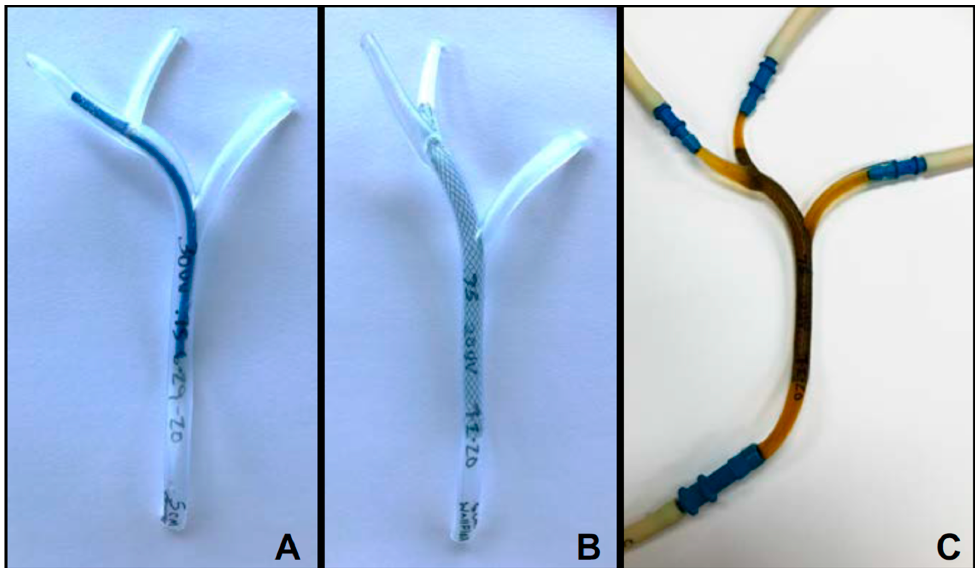
Figure 6. In vitro testing of biliary stents in the Elastic EHBD model. ( A ) Plastic biliary stent (7 F, 50 mm, Flexima) deployed into the right hepatic duct. ( B ) Uncovered SEM (8 mm × 60 mm Wallflex) deployed into the left hepatic duct. ( C ) Elastic EHBD with uncovered SEM deployed connected in line with a peristaltic pump, pulse dampener and bile acid solution reservoir. Bile acid solution was pumped through the model at 0.5 mL /